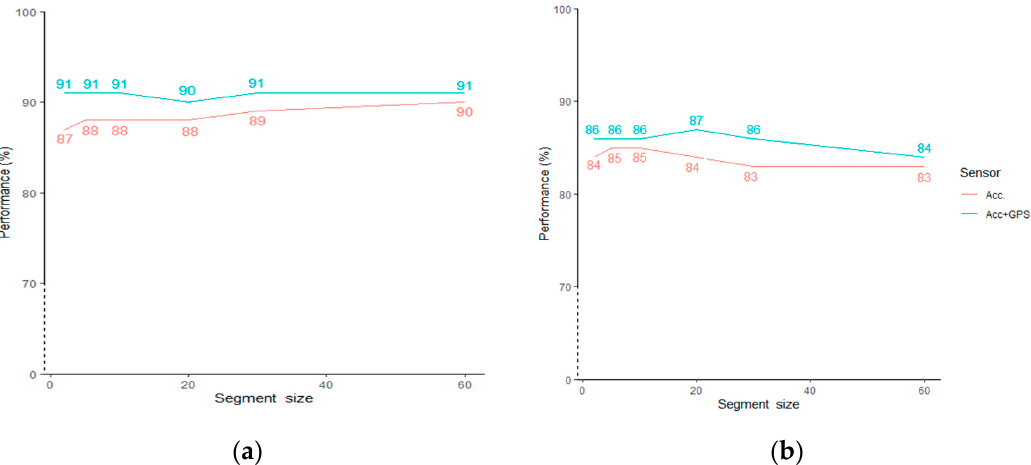
Figure 7. Sensitivity analysis on segment size, ( a ) general model trained with semi-structured dataset and ( b ) general model trained with combined dataset.